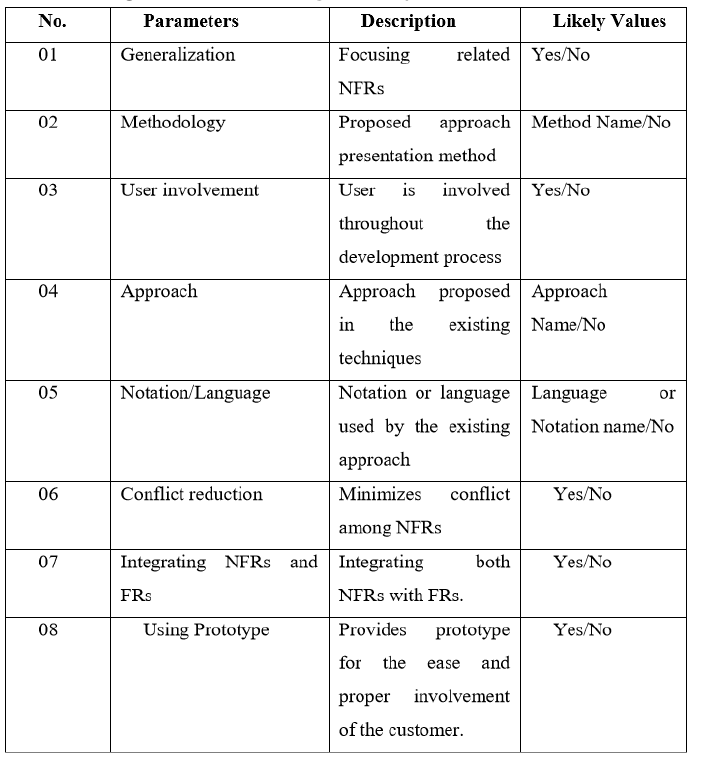
Figure 2 . Methodologies likely